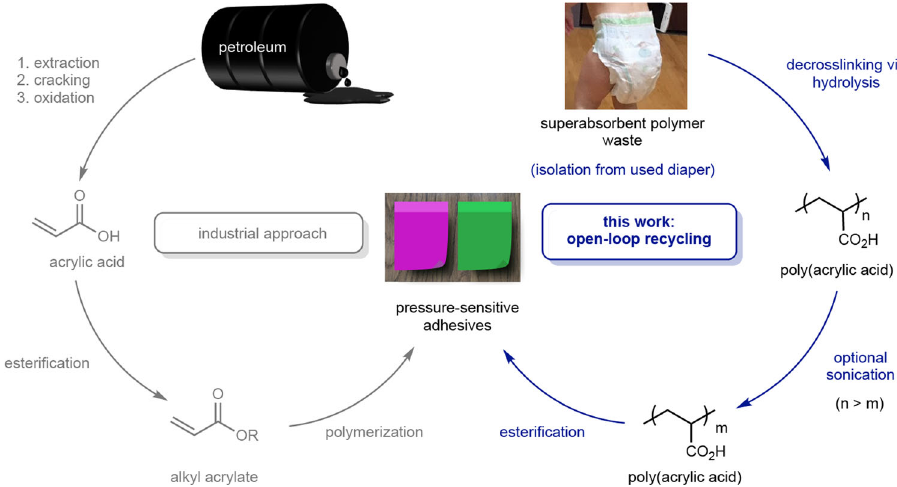
Fig. 1 Synthetic routes to pressure-sensitive adhesives. Syntheses of pressure-sensitive adhesives from petroleum feedstocks (industrial approach) compared to waste diaper-based feedstock (open-loop recycling).